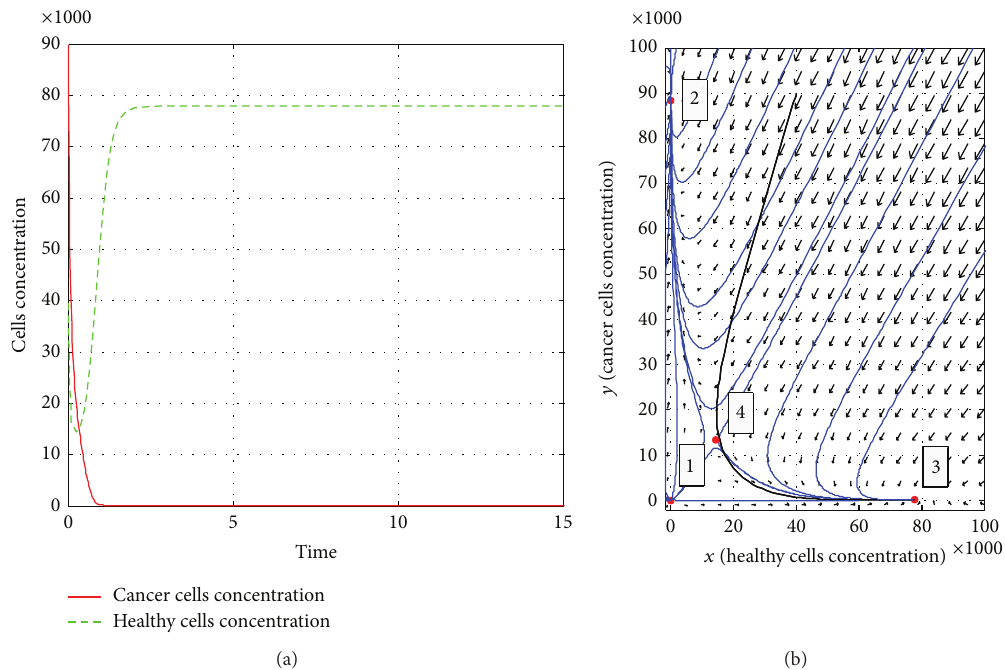
Figure 2: The behavior of the system during chemotherapy: (a) the time evolution of the system; (b) trajectory pattern of the system and system response after vaccine therapy.